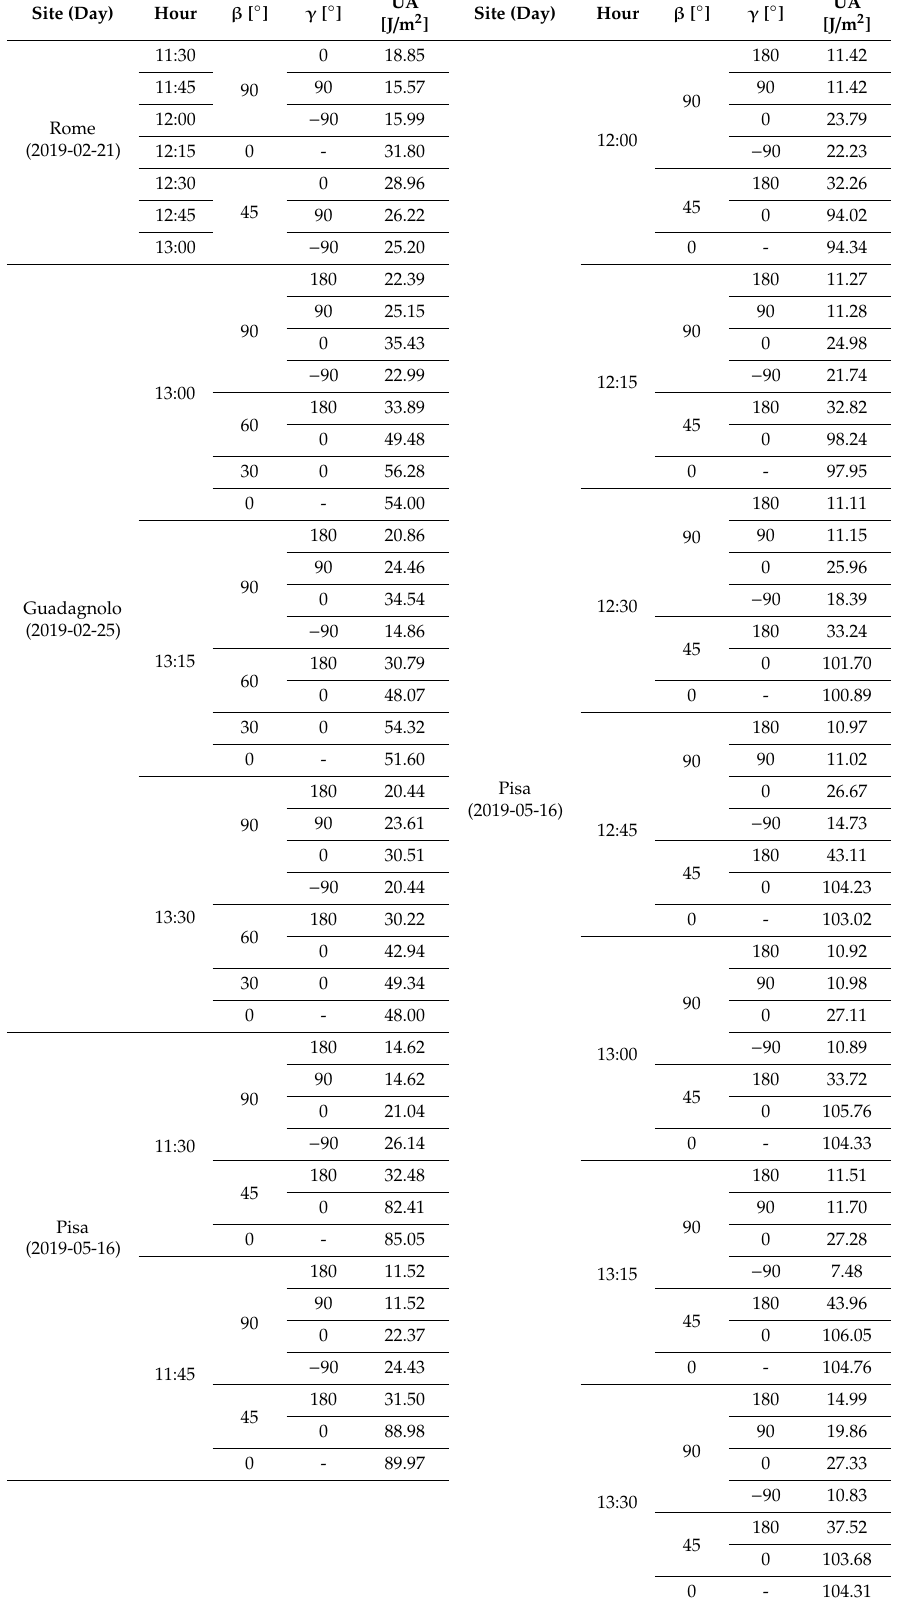
Table 9. U A values calculated with the algorithm in the three considered sites for horizontal and sloped surfaces facing the four cardinal